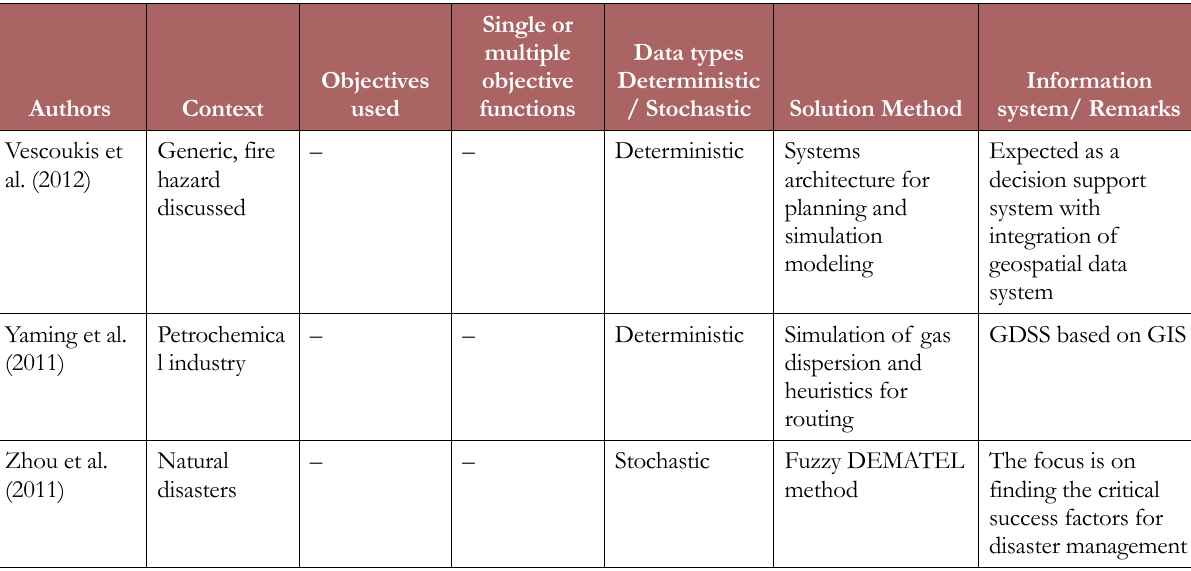
Table 3. Models and framework for corrective